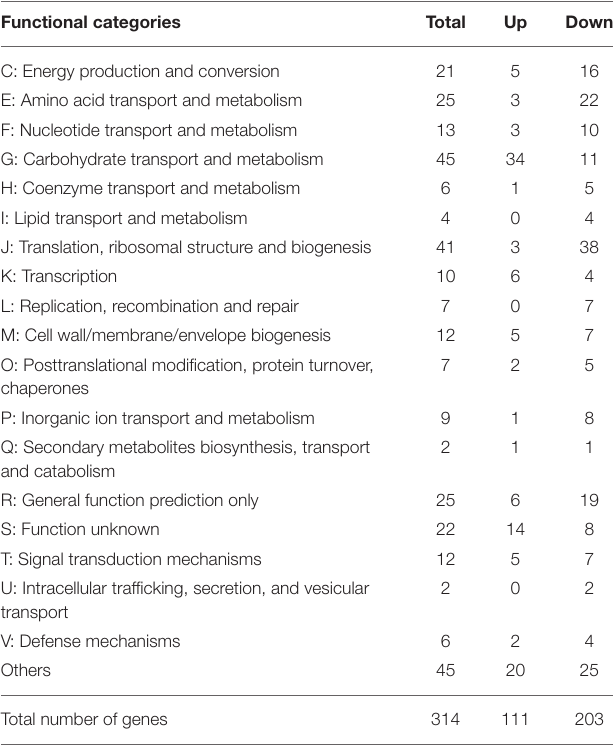
TABLE 5 | Number of genes significantly affected in D39 1 ccpA compared to the D39 wild-type grown in NAGaM17 (0.5% NAGa + M17). Functional